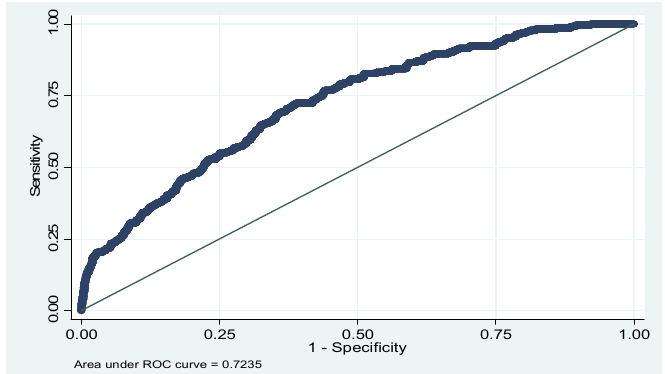
Fig. 1. ROC Curve (Model Evaluation) Source: Stata 12.0